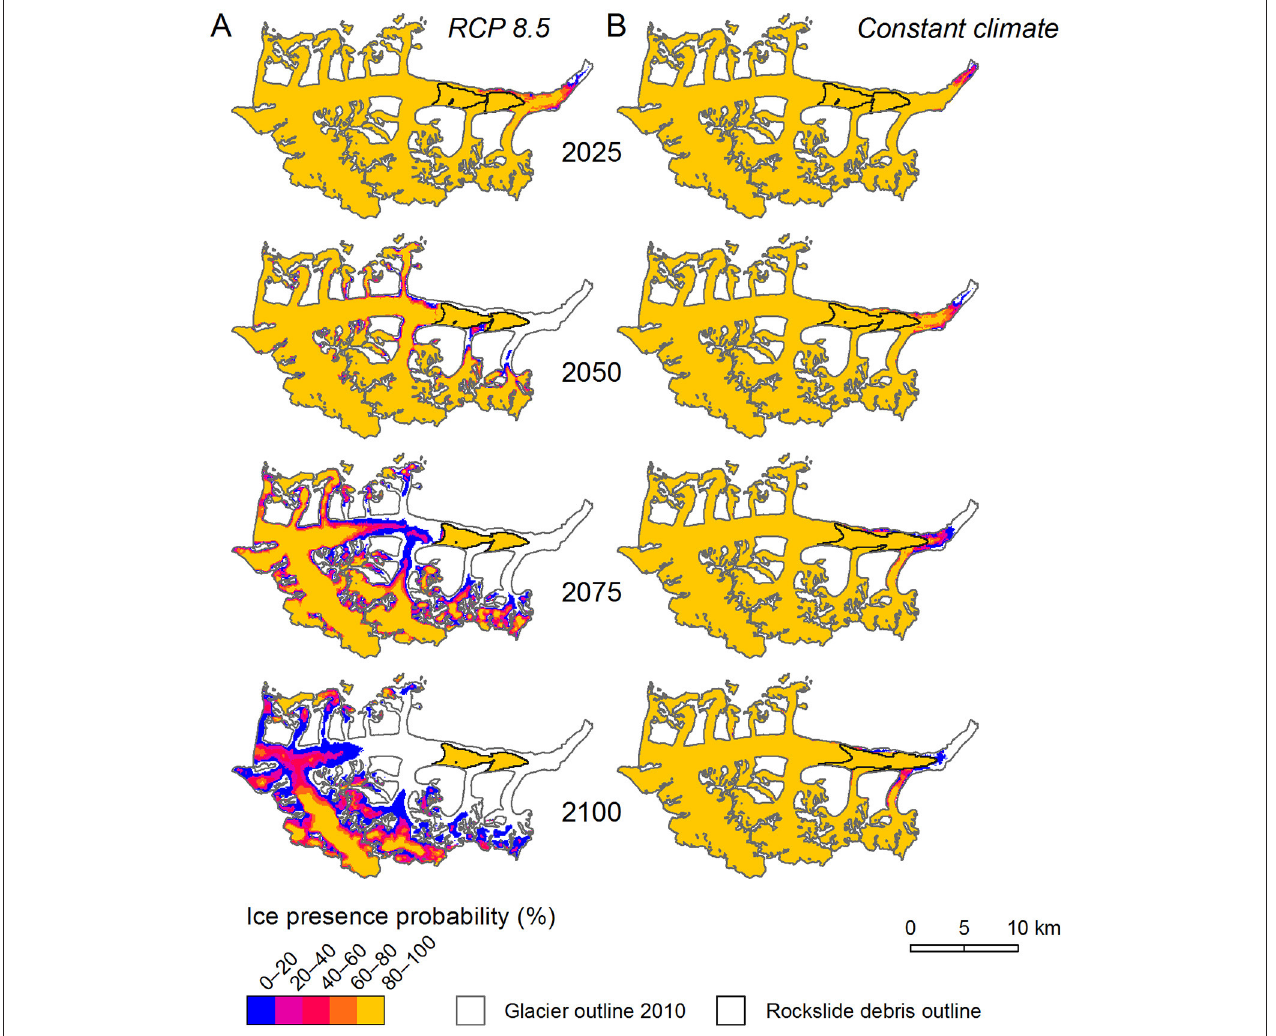
FIGURE 12 | Probability of the presence of ice for the years 2025, 2050, 2075, and 2100 for (A) the RCP 8.5 and (B) the constant climate scenarios. The probabilities are calculated from the stacked extents, where one extent reflects one Monte Carlo run. The locations of the rockslide debris are shown with black outlines. Note that this figure shows areal changes. Thinning may occur even if the ice presence probability is